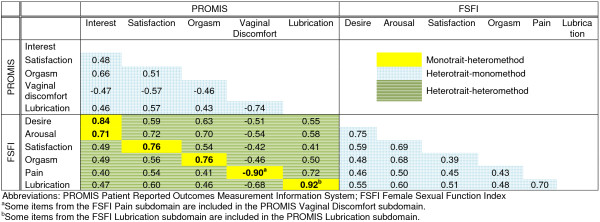
Correlations for women (N=429).